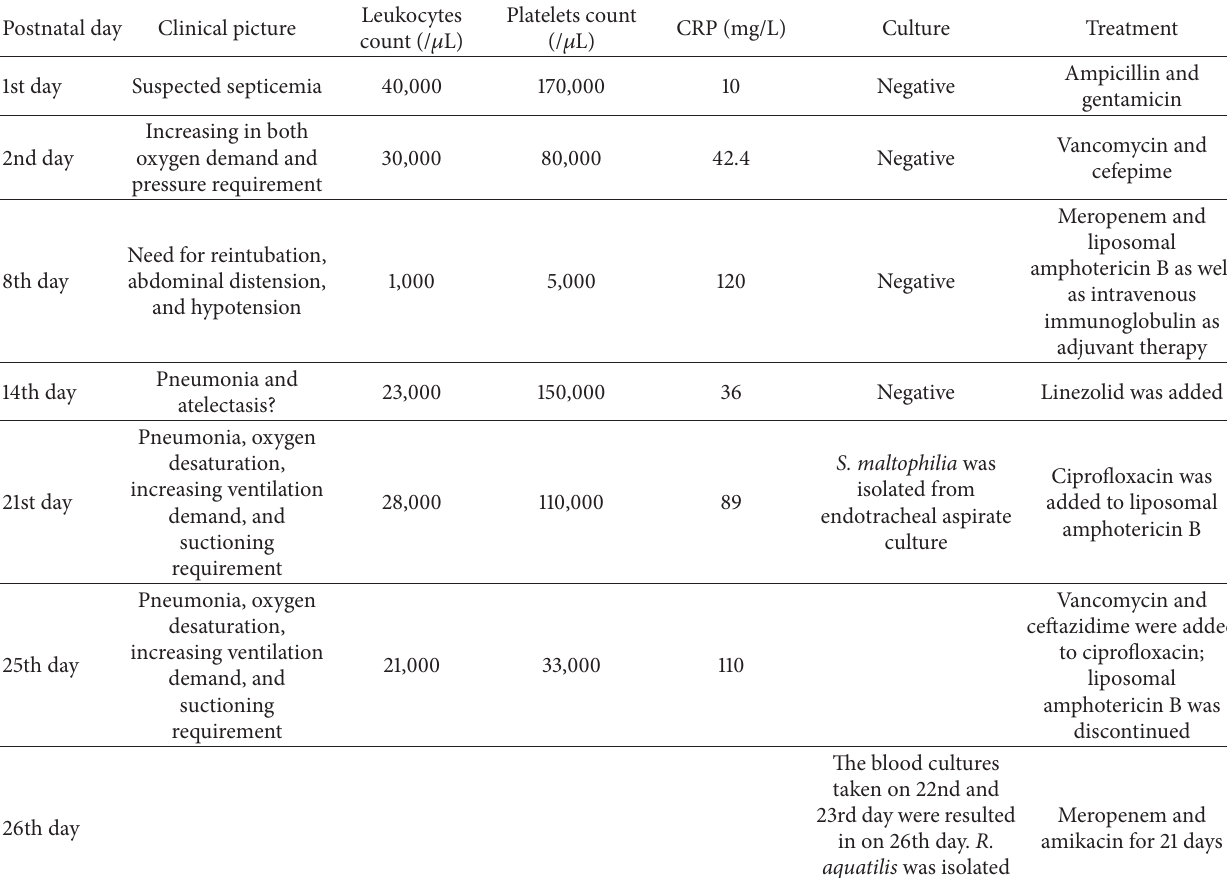
Table 1: All the patient’s significant laboratory/microbiological findings and the corresponding therapeutical